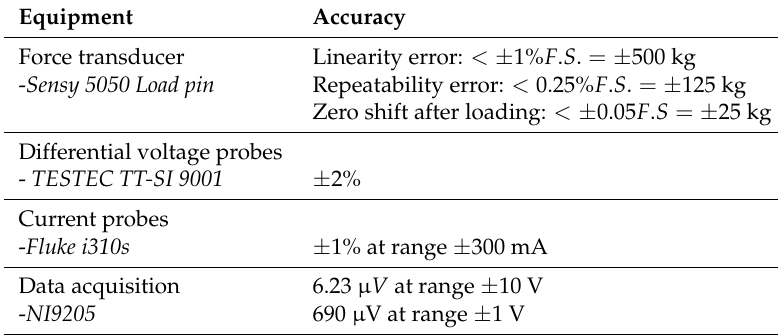
Table 2. Measurement equipment and their